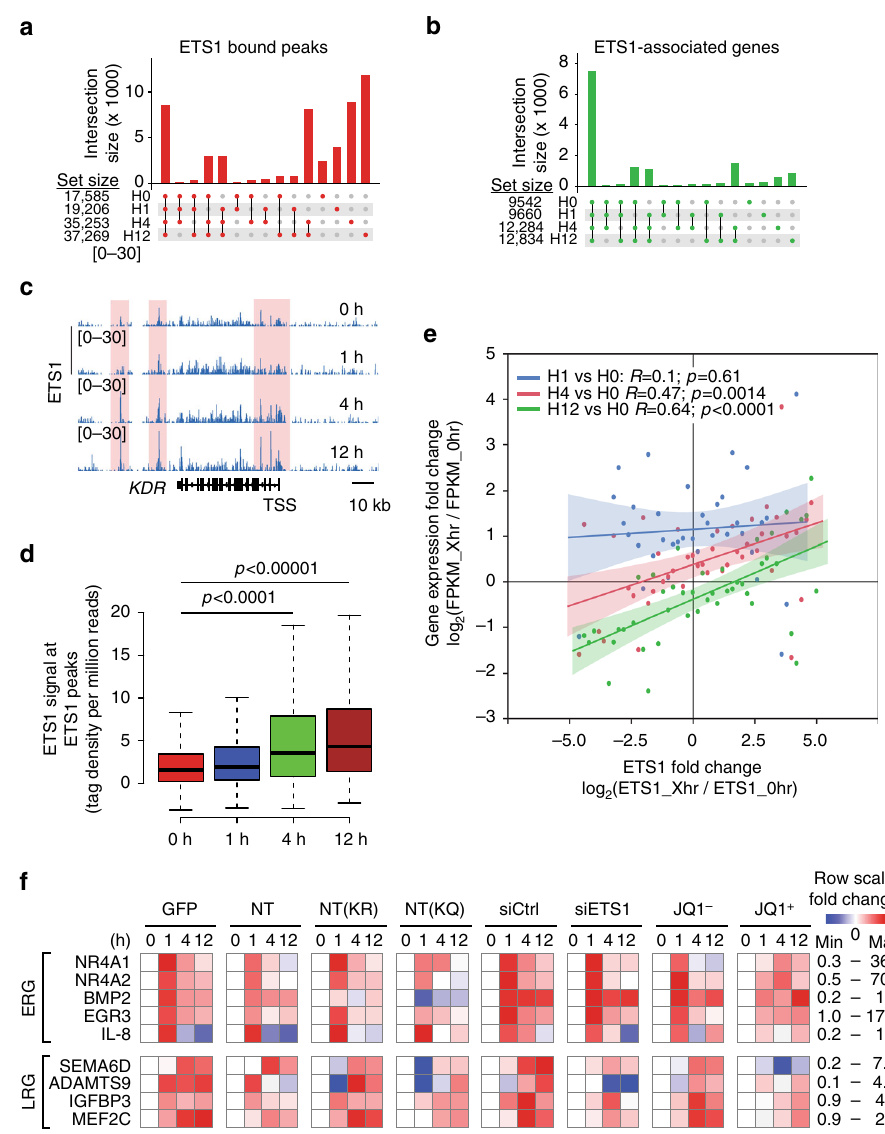
Fig. 5 ETS1 ampli fi ed VEGF downstream transcription. a , b UpSet plots 45 showing the overlap of ETS1-bound peaks ( a ) or ETS1-associated genes ( b ) between the four time points (0, 1, 4, 12 h). The bar represents the number of peaks shared by the time points indicated by the colored dots and not by the time points indicated by the gray dots . Most ETS1 peaks were not shared between time points, but most ETS1-associated genes were shared. c VEGF stimulated ETS1 chromatin occupancy. Genome browser view of ETS1 occupancy at the KDR locus at the indicated times of VEGF stimulation. Pink highlights regions with greater VEGF occupancy over the time course. d Genome-wide gain of ETS1 signal at ETS1-bound regions during VEGF stimulation time course. ETS1 binding increased genome-wide at 4 and 12 h. Mann – Whitney U -test. Dark line and boxes represent the median and 25th and 75th percentiles. The whiskers represent median ± 1.5 times the interquartile range. e . VEGF-induced changes in gene expression correlated to changes in ETS1 promoter occupancy. Analysis was limited to expressed genes with ETS1 promoter occupancy. Expression and ETS1 signal at the indicated time point of VEGF treatment are expressed as fold change compared to hour 0. Each point was calculated by grouping genes with similar ETS1 occupancy change. Correlation and p -values were plotted using a linear regression model. f VEGF-induced gene activation requires ETS1 – BRD4 interaction. HUVEC cells were transduced with lentivirus expressing the indicated proteins, transfected with siRNA, or treated with small molecule JQ1. Gene expression after the indicated number of hours of VEGF stimulation was measured by qRT-PCR and displayed as a heat map. Log 10 fold-change compared to time 0 was row scaled. Linear minimum and maximum fold-change values for each row are listed on the (Supplementary Fig. 5a, b). By inhibiting endogenous ETS1 – BRD4 interaction, we anticipated that ETS1-NT would have dominant negative activity. Since NT-K8;18R (abbreviated NT(KR)) reduced BRD4 af fi nity, we expected that this mutation would attenuate dominant negative activity. Similarly, NT-K8;18Q (abbreviated NT(KQ)) enhanced BRD4 af fi nity, leading us to expect that this mutation would enhance dominant negative activity. HUVEC expressing these peptides were treated with VEGF, and the